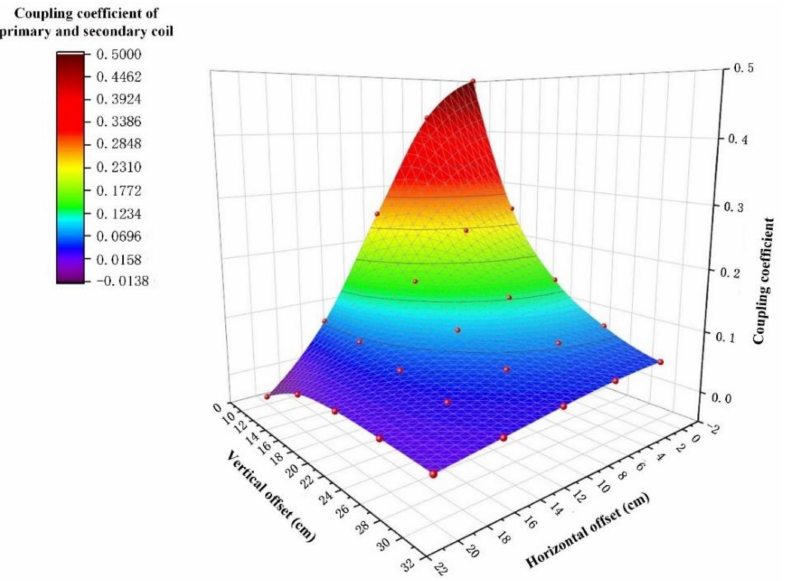
Figure 6. The relationship among horizontal, vertical misalignment, and the coupling coefficient of the circular